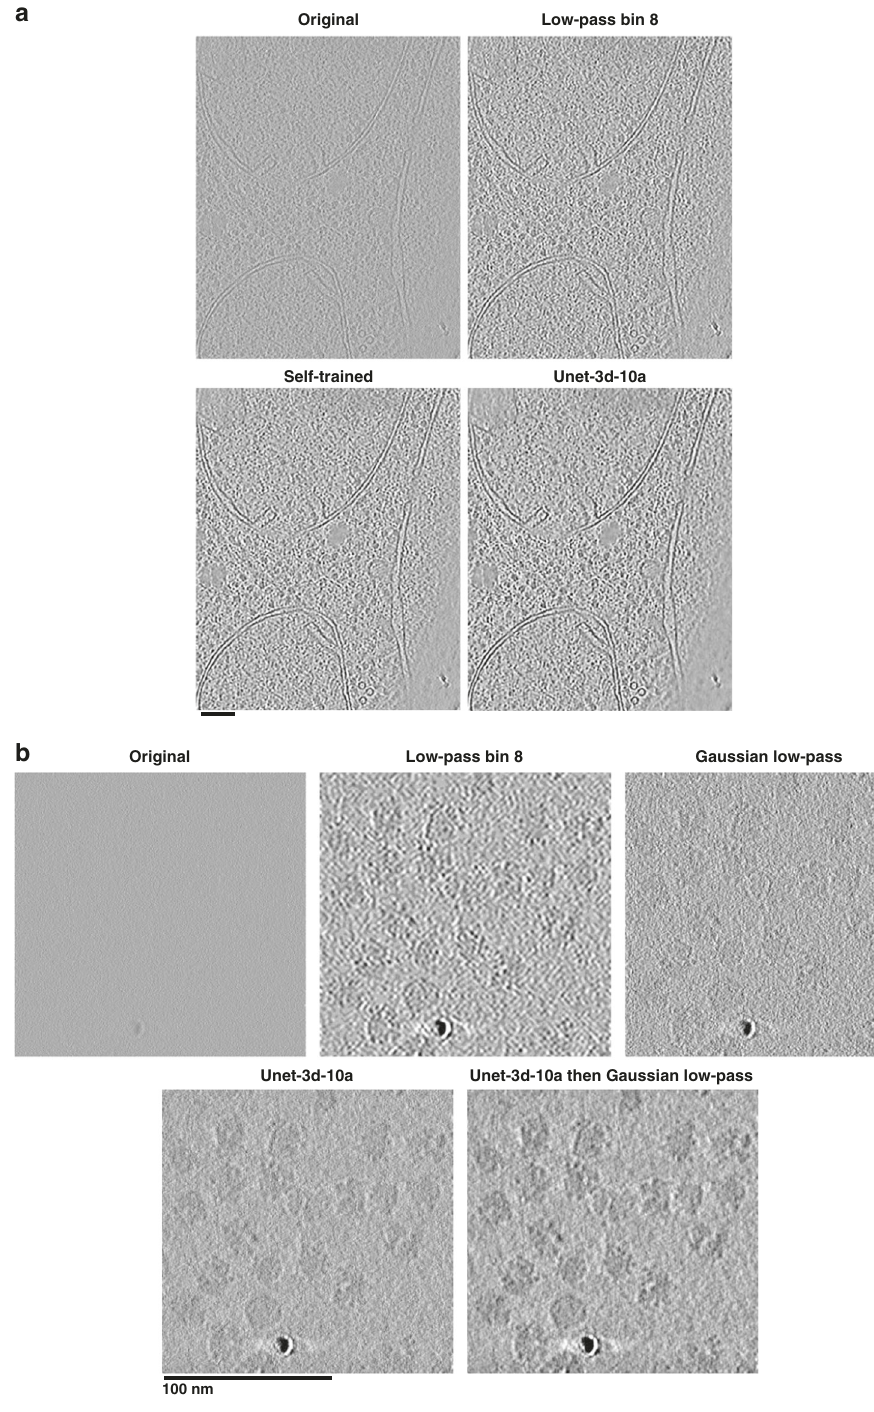
Fig. 4 Denoising with the 3D general model in Topaz improves cellular and single particle tomogram interpretability. a Saccharomyces uvarum lamellae cryoET slice-through (collected at 6 Å pixelsize and 18 microns defocus, then binned by 2). The general denoising model (Unet-3d-10a) is comparable visually and by SNR to the model trained on the tomogram ’ s even/odd halves (Self-trained). Both denoising models show an improvement in protein and membrane contrast over binning by 8 while con fi dently retaining features of interest, such as proteins between membrane bilayers. Both denoising models also properly smooth areas with minimal protein/membrane density compared to the binning by 8. See Supplementary Movie 1 for the tomogram slice-throughs. b 80S ribosomes as single particles (EMPIAR-10045; collected at 2.17 Å pixelsize and 4 microns defocus). The general denoising model (Unet-3d-10a) is markedly improved over binning by 8 and the 1/8 Nyquist Gaussian low-pass, both with smoothing background appropriately while increasing contrast and with retaining features of interest at high fi delity, such as the RNA binding pocket in all orientations. The same 1/8 Nyquist Gaussian low-pass applied to the denoised tomogram further improves contrast by suppressing high-frequencies that the user may deem unimportant. See Supplementary Movie 2 for the tomogram